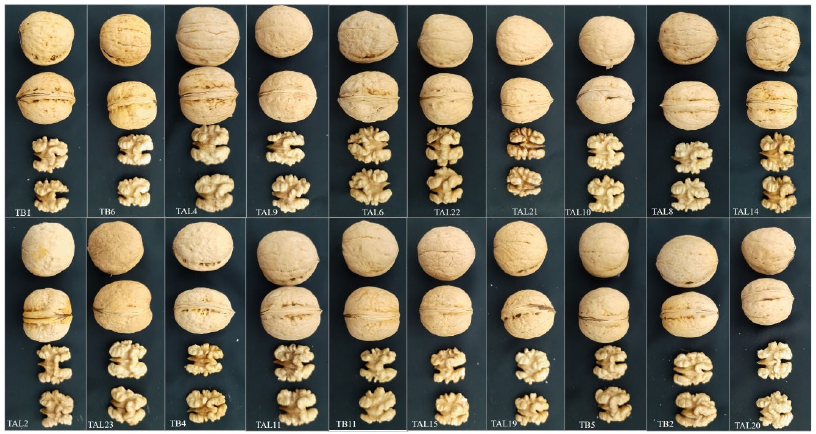
Figure 3. Kernels and nuts corresponding to some walnut genotypes in this study were obtained from germplasm evaluation.